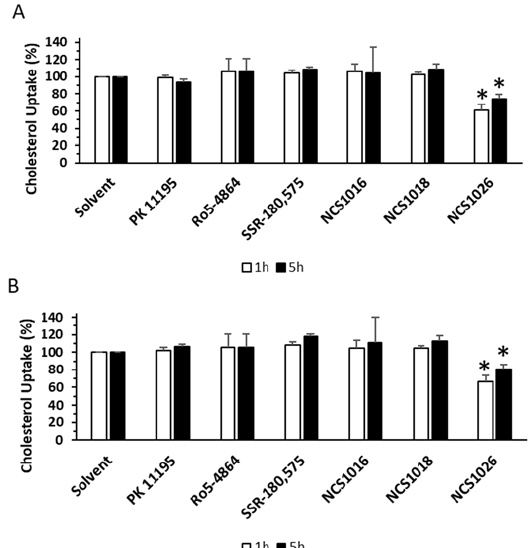
Figure 5. Cholesterol uptake induced by TSPO ligands. Healthy ( A ) or infected red blood cells, at 2 to 5% parasitemia ( B ) were incubated in the presence of TopFluor Cholesterol and 50 µM of TSPO ligands. Cholesterol uptake was assessed at different time points by flow cytometry. MFI values were normalized to vehicle treated cells. Data are presented as mean ± SEM; N = 4. Differences between each ligand and control condition (vehicle) were considered significant when * p < 0.05.